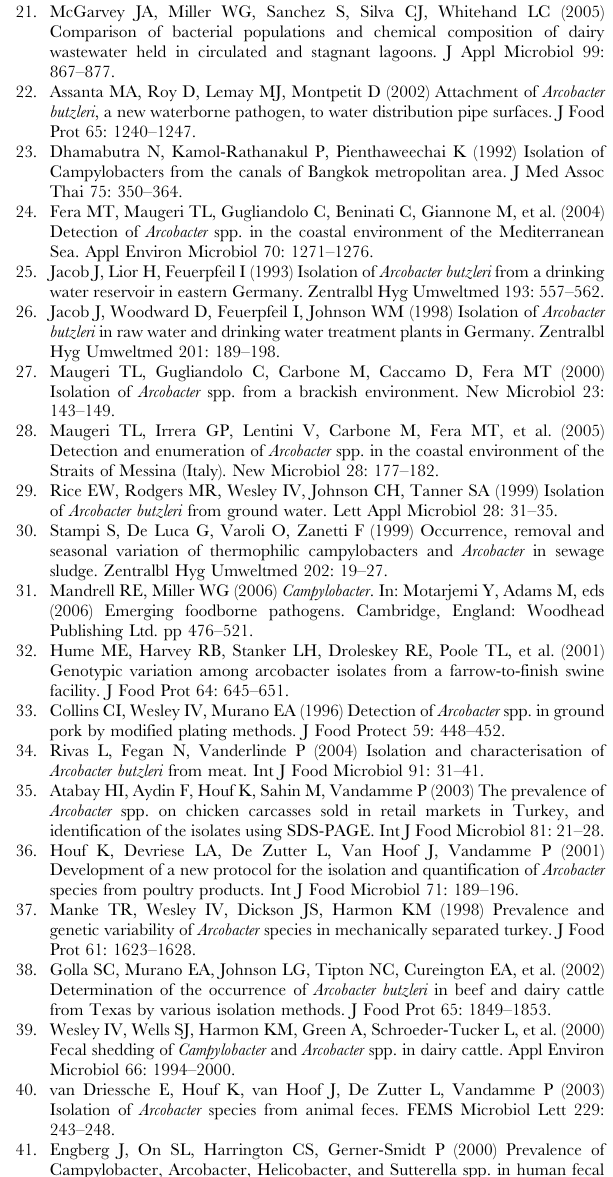
Table S7 CDS present only in A. butzleri strain RM4018. Set of 42 genes identified by comparative genomic indexing of 13 A. butzleri strains to be present only in strain RM4018. The functional annotation of each gene is